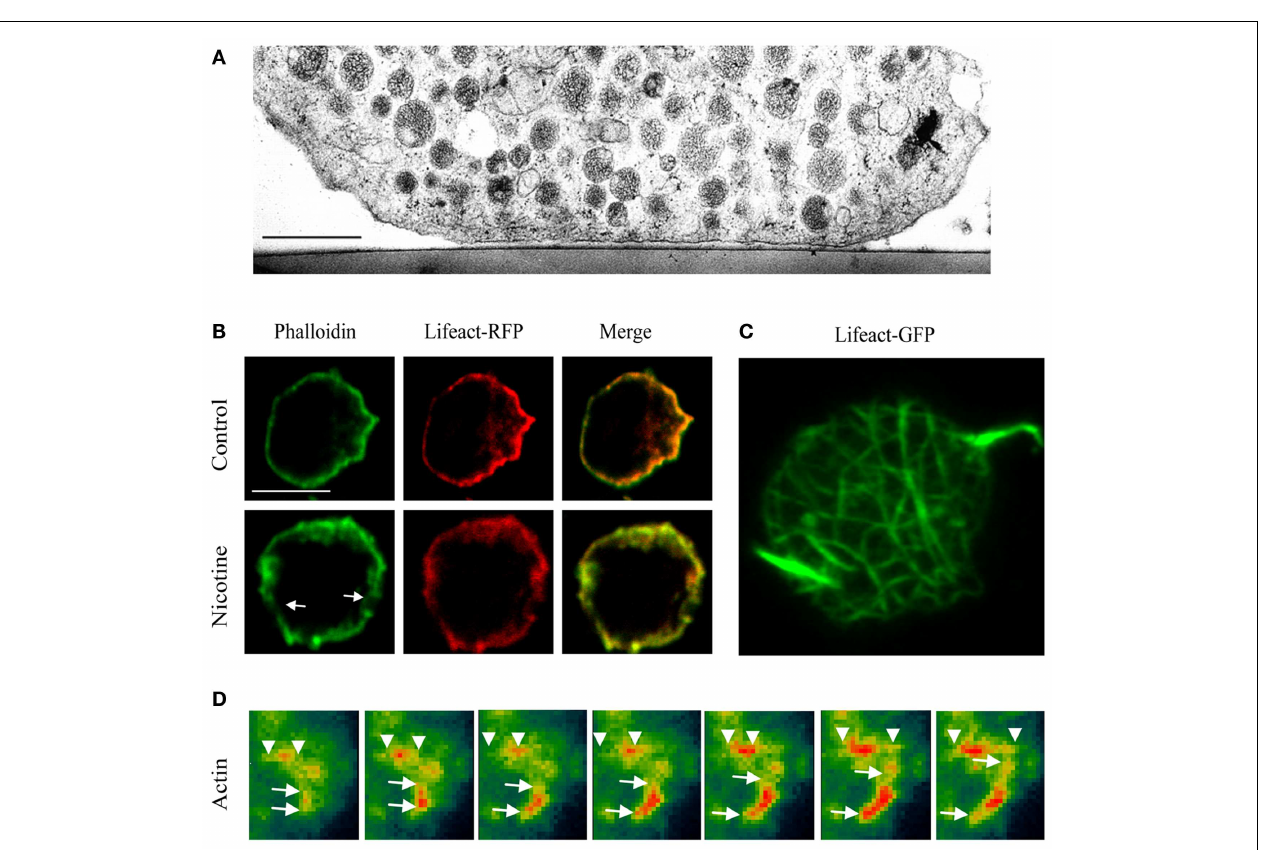
counter stained with FITC-conjugated phalloidin in the presence or absence of nicotine (50 µ M). (C) Maximum intensity projection of the footprint of a chromaffin cell. (D) TIRF images showing actin lengthening in a chromaffin cell expressing lifeact-GFP (pseudocolor) after the addition of PI3K δ inhibitor IC87114. (B–D) Adapted from Ref.